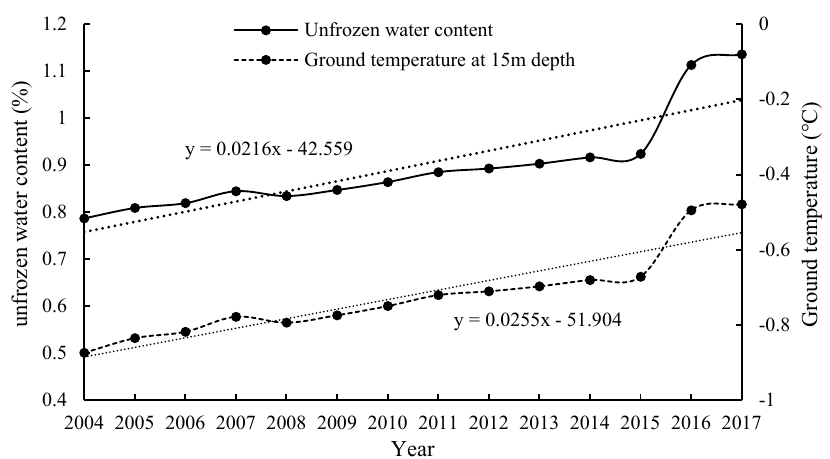
Figure 11. The change in unfrozen water content with the ground temperature of the permafrost.